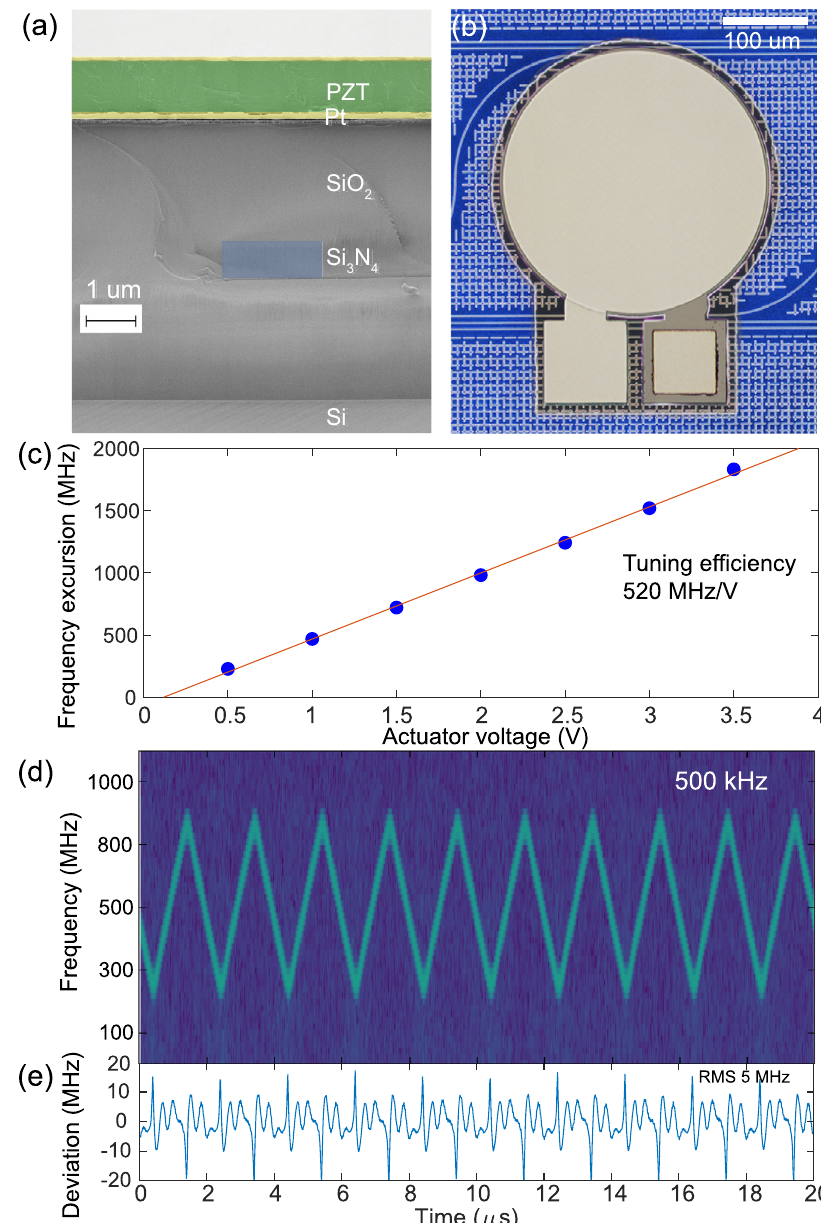
Fig. 5 Low voltage fast tuning with integrated PZT piezoactuator. a False-coloured SEM image of the sample cross-section, showing the PZT actuator integrated on the Si 3 N 4 photonic circuit. The piezoelectric actuator is composed of Pt (yellow), PZT (green) layers on top of Si 3 N 4 (blue) buried in SiO 2 cladding. b Optical micrograph of disk-shaped PZT actuator on top of Si 3 N 4 microring with 100 GHz FSR. c Frequency excursion as a function of the voltage applied to the PZT actuator, measured at 81 kHz triangular chirping rate. Linear fi t (red) provides 520 MHz/V tuning ef fi ciency. d Time-frequency spectrogram of the heterodyne beat-note for 500 kHz triangular chirp repetition frequency with 1.1 V applied to the PZT actuator. e Residual of least- squares fi tting of the time-frequency trace with symmetric triangular chirp